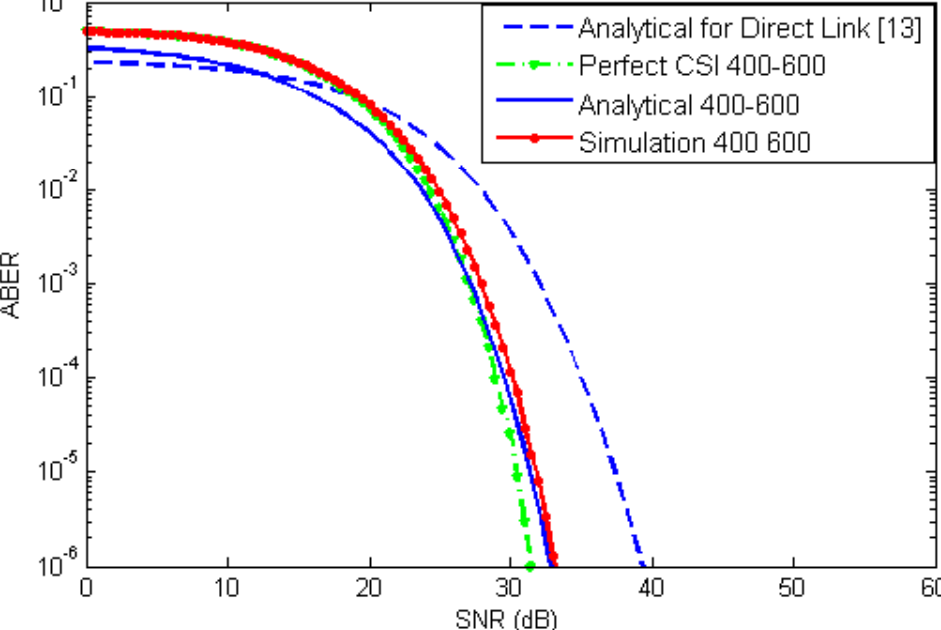
Figure 4. ABER performance for the direct link and a single relay after 600 m from the source, over weak turbulence.